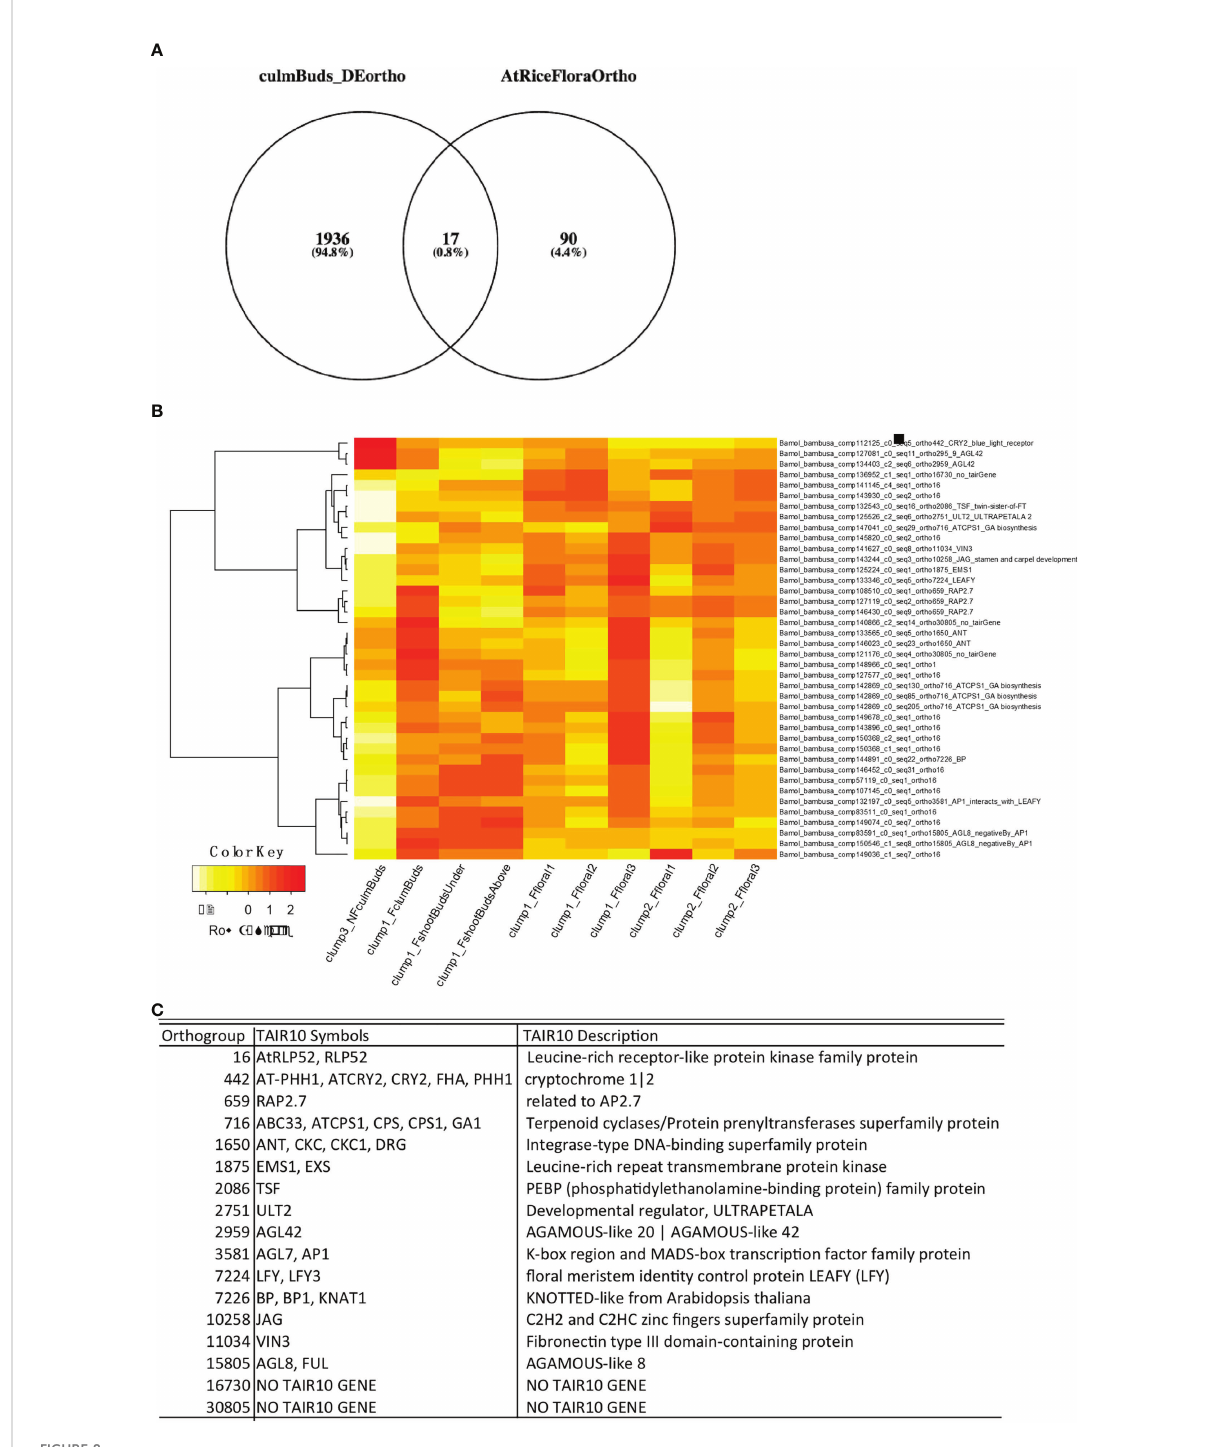
FIGURE 8 Early fl oral initiation genes in B. oldhamii ‘ Xia Zao ’ . (A) Genes from 17 fl oral orthogroups were differentially expressed in culm buds stages in bamboo fl owering tissues. (B) Gene expression heatmap of B. oldhamii ‘ Xia Zao ’ orthologs of known fl oral initiation genes curated in Arabidopsis . (C) The description of the 17 fl oral initiation